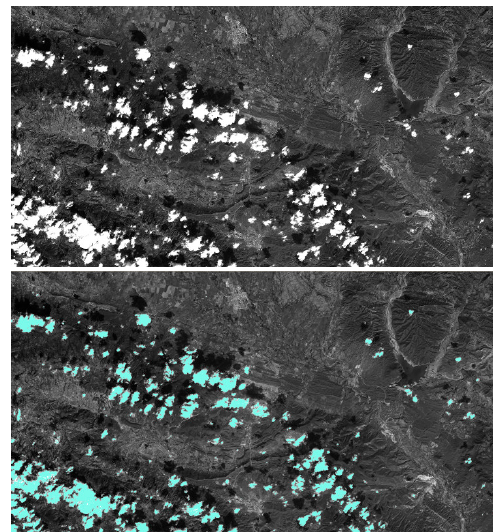
Figure 1. (top) Initial panchromatic SPOT5-HRS ortho-image. (bottom) The outcomes of our cloud detection algorithm (pixels labelled clouds in